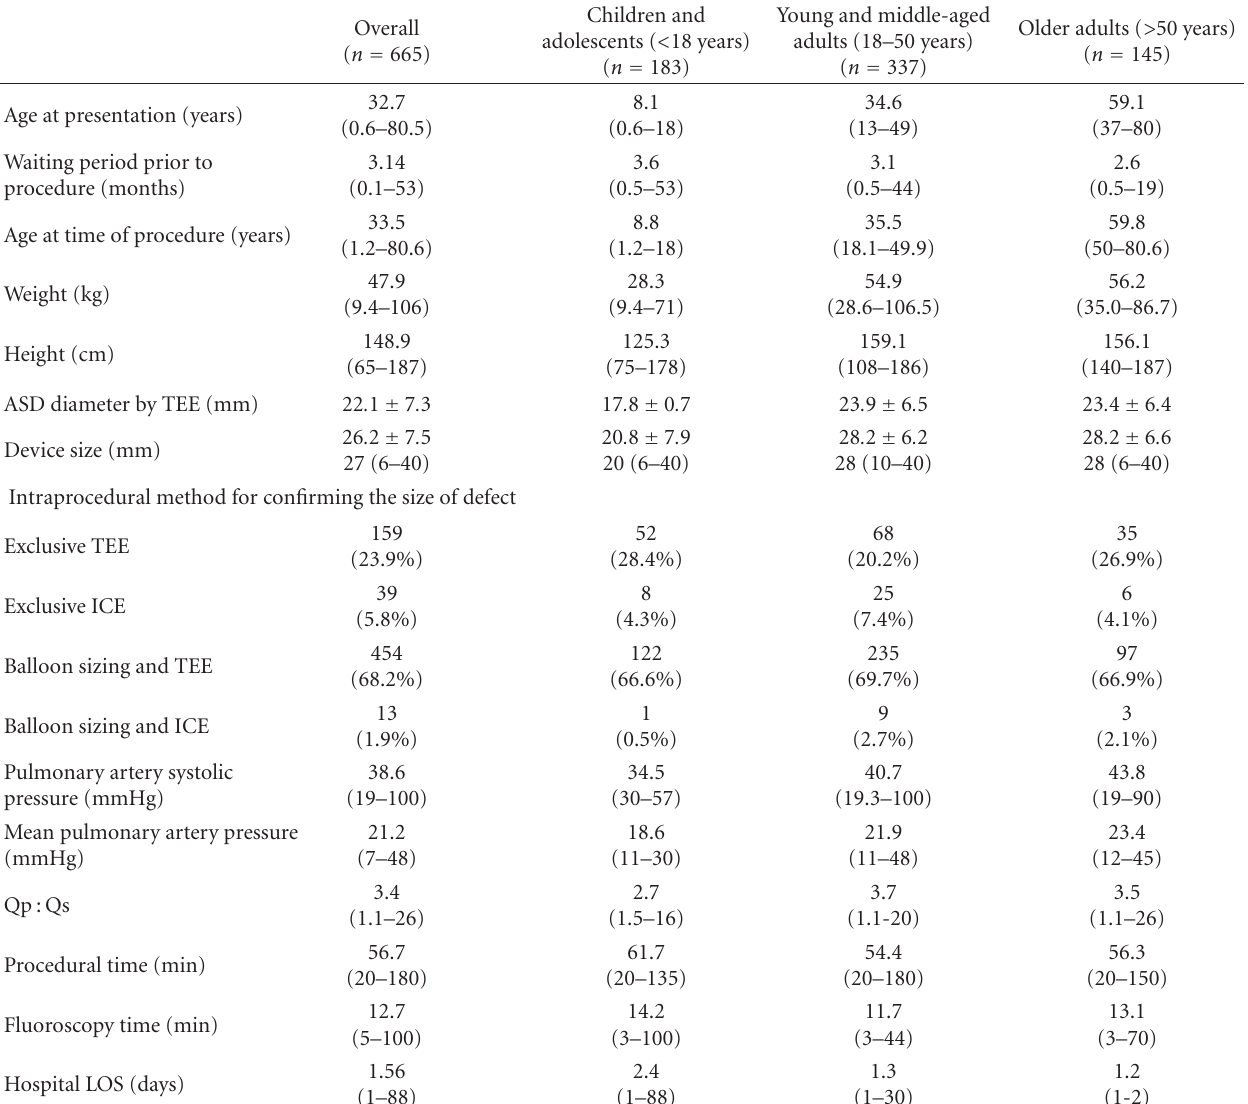
Table 1: Patients’ baseline characteristics ( n = 665).